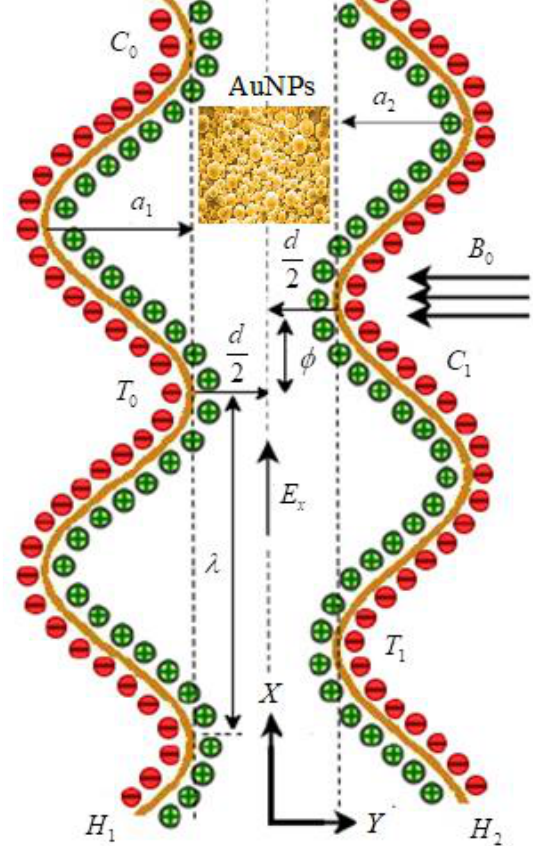
Figure 1. Schematic flow representation in the presence of EMHD and gold nanoparticles. The governing equations (continuity, momentum, energy, nanoparticle volume frac- tion and microorganisms) for the nanofluid flow in the fixed frame are expressed as [38 – 40].